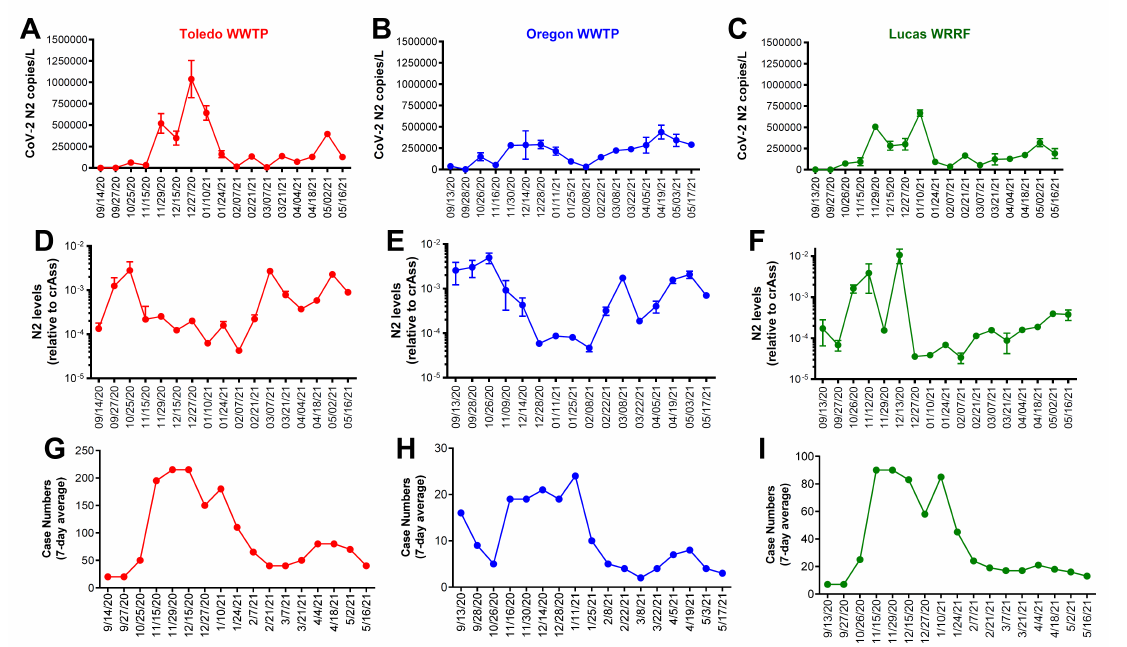
Figure 3. The analyses of the SARS-CoV-2 gene copies in the samples collected from the Toledo area WWTPs in the TOLWMN program. ( A – C ) SARS-CoV-2 viral N mRNA levels (copies/L) were analyzed by qRT-PCR. ( D – F ) The levels of SARS-CoV-2 viral N mRNA relative to the crAssphage.